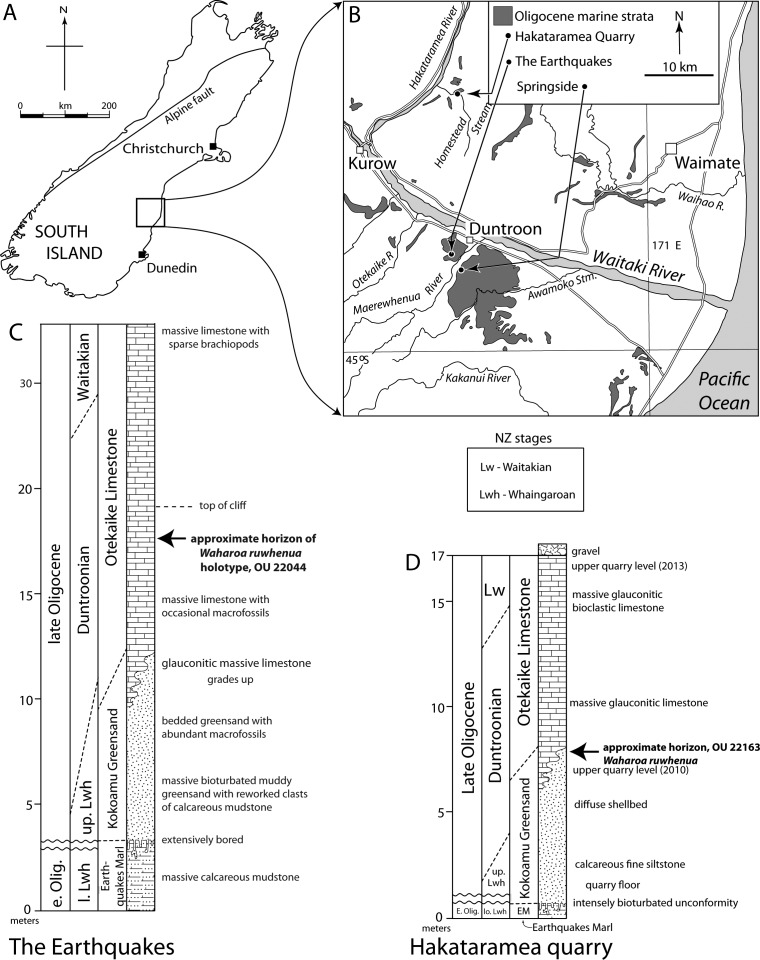
Geologic and geographic context of Waharoa ruwhenua localities.(A) map of South Island, New Zealand; (B) map of Waitaki Valley Regions showing location of Hakataramea Quarry, “The Earthquakes,” and Springside; (C), stratigraphic column of “The Earthquakes,” modified from Fordyce (1994); (D), stratigraphic column of Hakataramea Quarry, modified from (Gottfried, Fordyce & Rust, 2012).